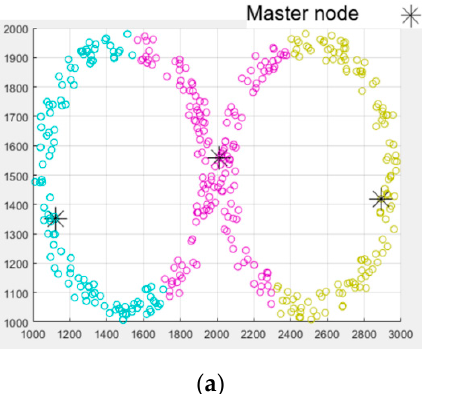
Figure 14. SIP distribution without edge conflict.